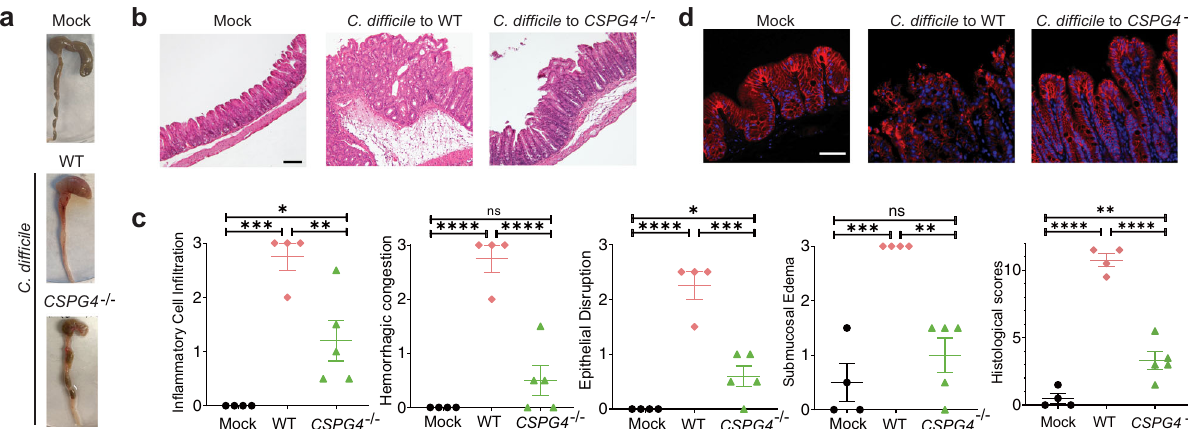
Fig. 4 CSPG4 is a physiological relevant cellular receptor for TcdB in vivo. a Three groups of infection experiment were performed: mock to WT ( n = 4); M7404, tcdA − to WT mice ( n = 8); and M7404, tcdA − to CSPG4 − / − mice ( n = 9). The representative cecum and colon of infected mice that were harvested at 48 h. The harvested cecum was processed with hematoxylin and eosin staining (scale bar represents 100 µ m, mock n = 4, C. dif fi cile to WT n = 4, C. dif fi cile to CSPG4 − / − n = 5) ( b ), scored based on in fl ammatory cell in fi ltration, hemorrhagic congestion, epithelial disruption, and submucosal edema ( c ), and subjected to immuno fl uorescence staining by epithelial cell junction marker Claudin-3 (scale bar represents 50 µ m, mock n = 3, C. dif fi